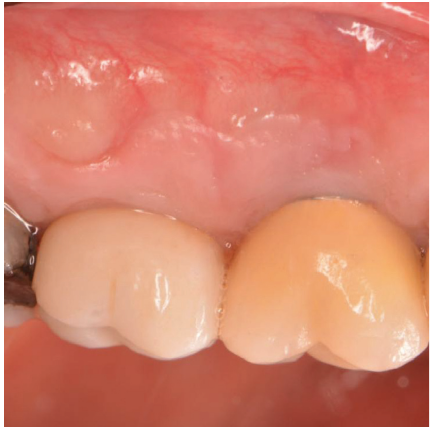
Figure 22: Clinical evaluation 13 months postoperatively showed no signs of